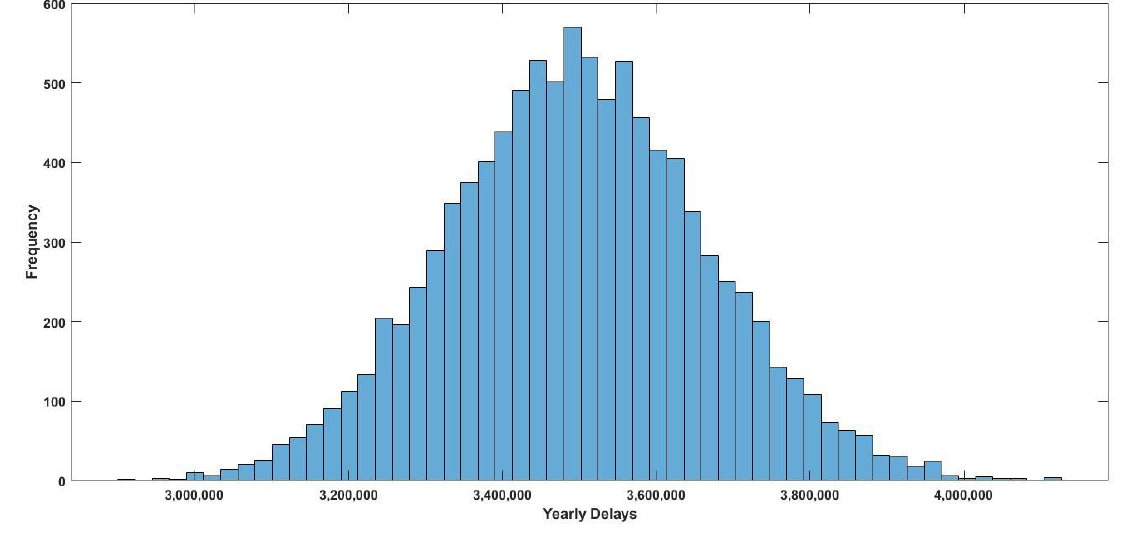
Figure 13. Simulation of yearly delays in